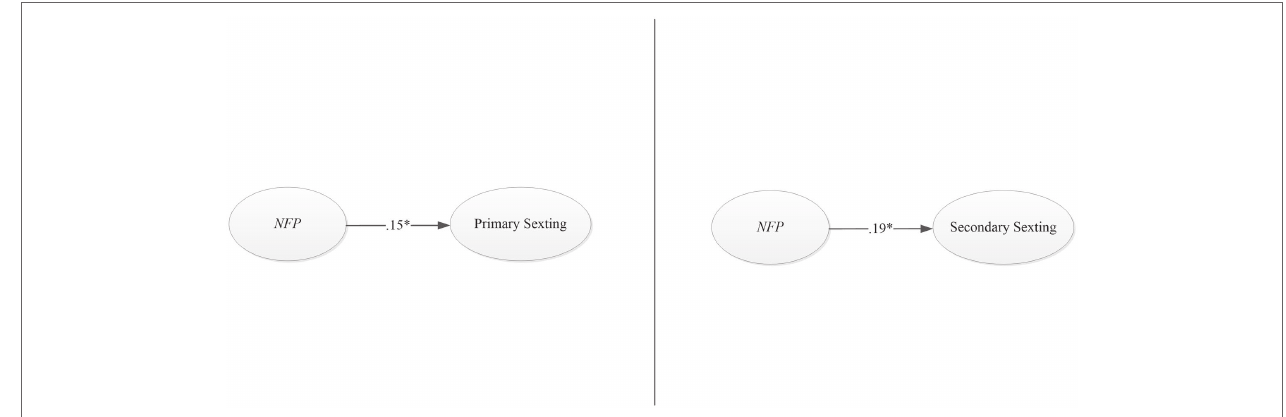
FIGURE 2 | Graphic solution of the models of Need for Popularity (NfP) to